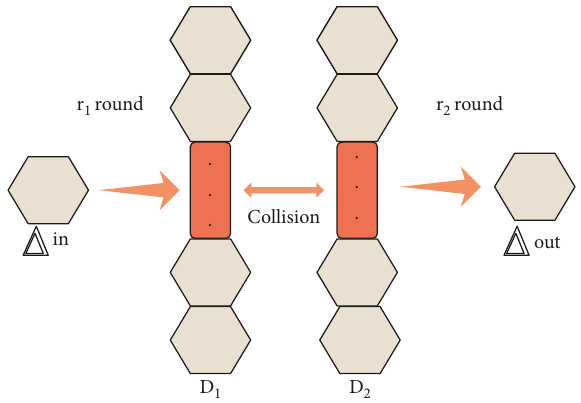
Figure 1: Differential enumeration